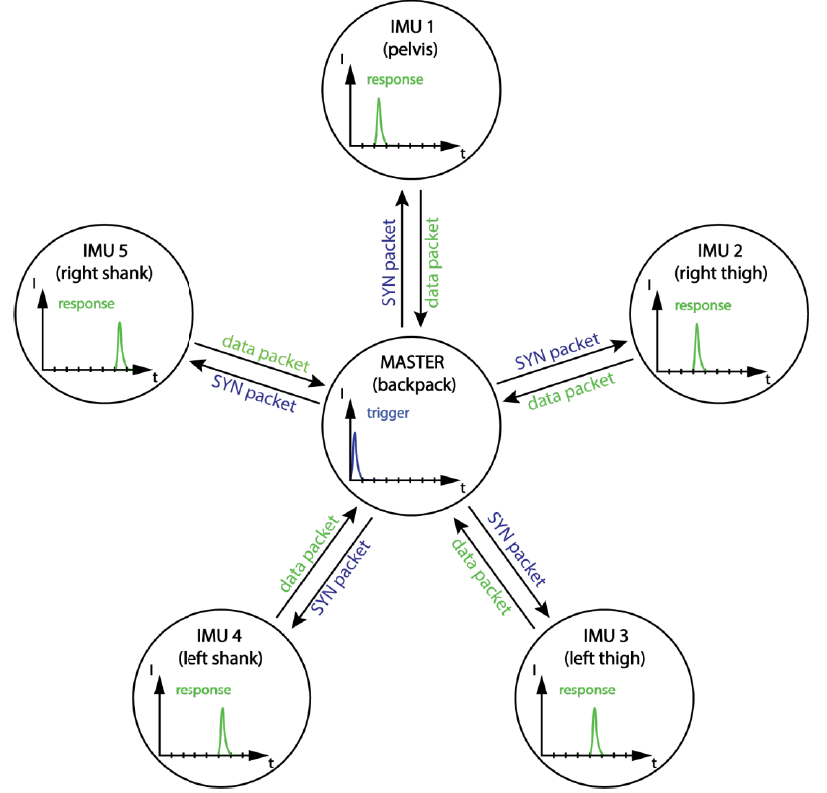
Figure 1. Star network topology of Wearable Sensory Apparatus for tracking the motion of body segments while walking.